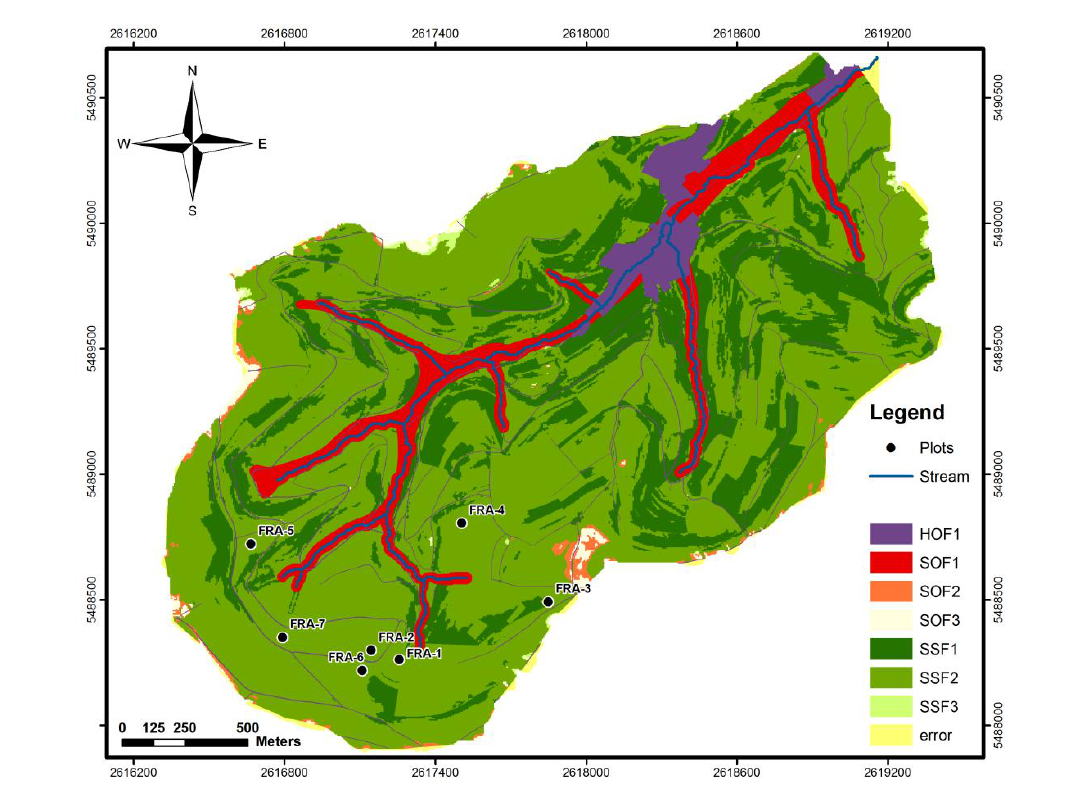
Figure 6. GIS-DRP map of the Frankelbach catchment, Rhineland-Palatinate (error = lack of basic